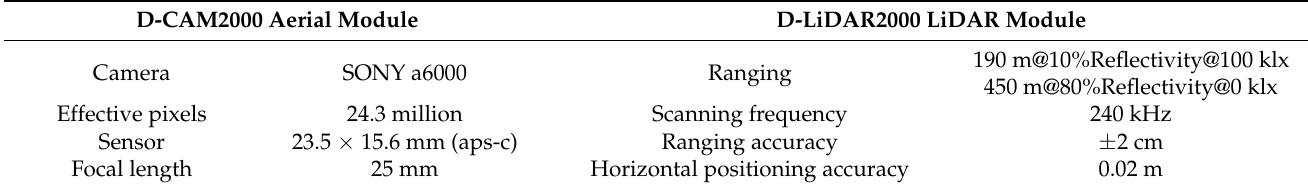
Table 2. Parameters configuration of aerial survey module and LiDAR module.